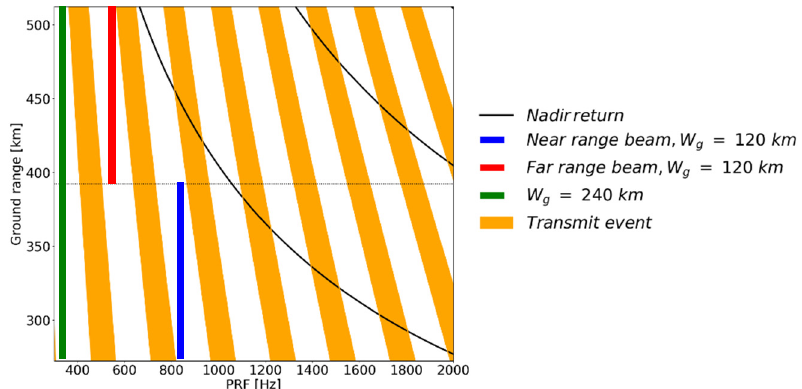
Figure 3. Timing diagram for a duty cycle of 20% The orange and black zones represent transmit and nadir interferences, respectively. The blue line represents the near range ground swath of 120 km, the red line represents the far range ground swath of 120 km, and the green line represents the 240 km ground swath.